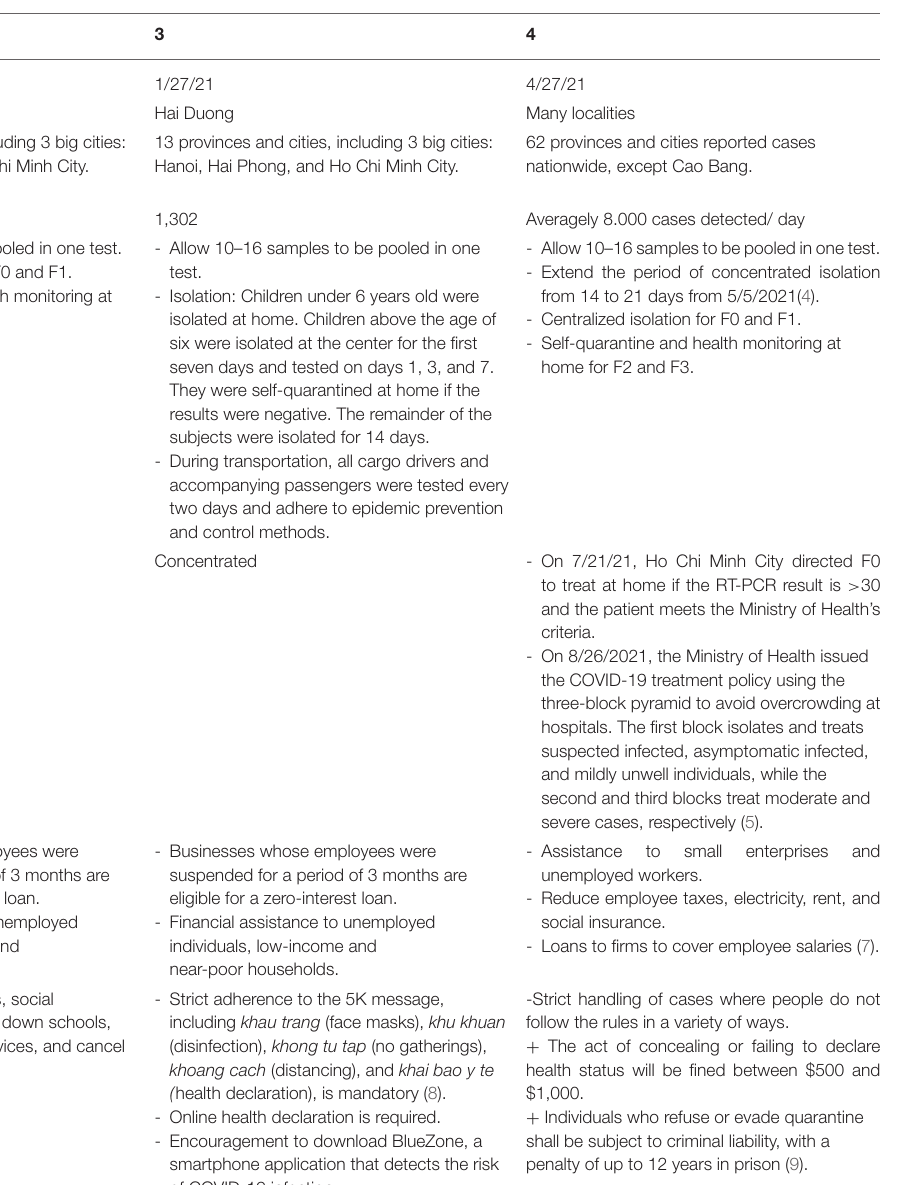
13 provinces and cities, including 3 big cities: Hanoi, Hai Phong, and Ho Chi Minh